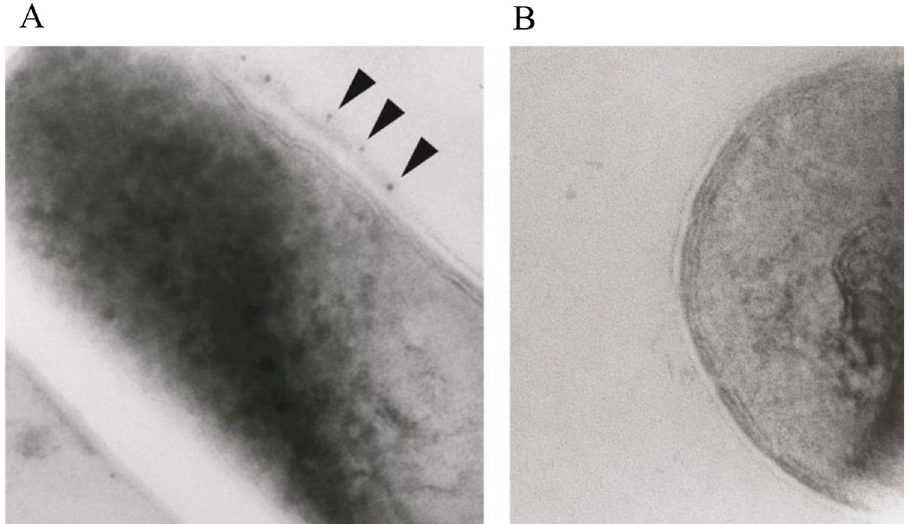
Fig 2. Colloidal gold immunoelectron microscopic analysis of M . leprae strain Thai 53. The bacilli were pretreated with (A) an Ab raised against r-45 kDa Mce1A protein and (B) coated beads with bovine serum albumin (BSA) fraction V which were used as negative controls and were followed by incubation with anti-IgG Ab-conjugated colloidal gold particles. Gold particles are shown decorating the surface of the M . leprae bacillus (arrowheads).